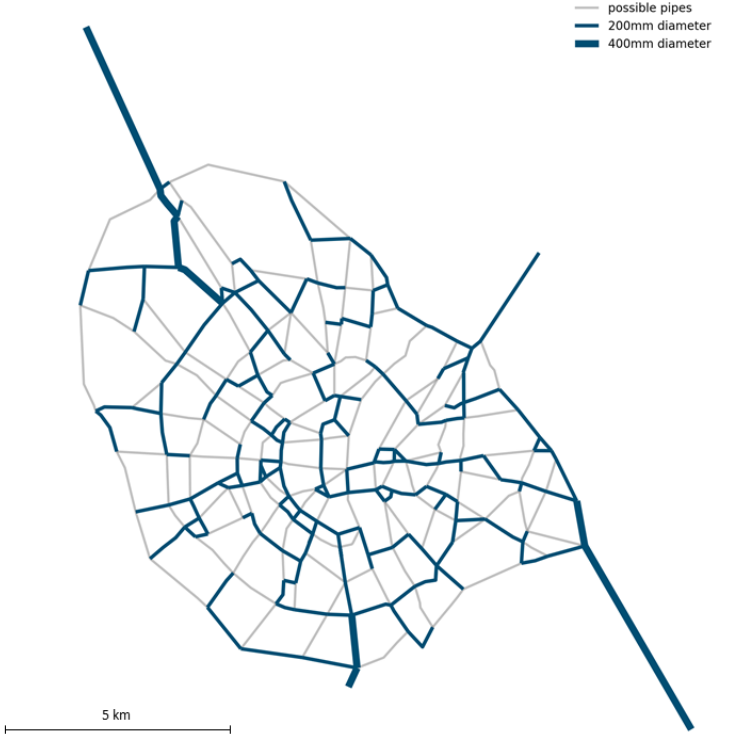
Figure 4. Cost-optimal WDS (blue) with different line widths to represent the change in pipe diameter and maximum possible network topology